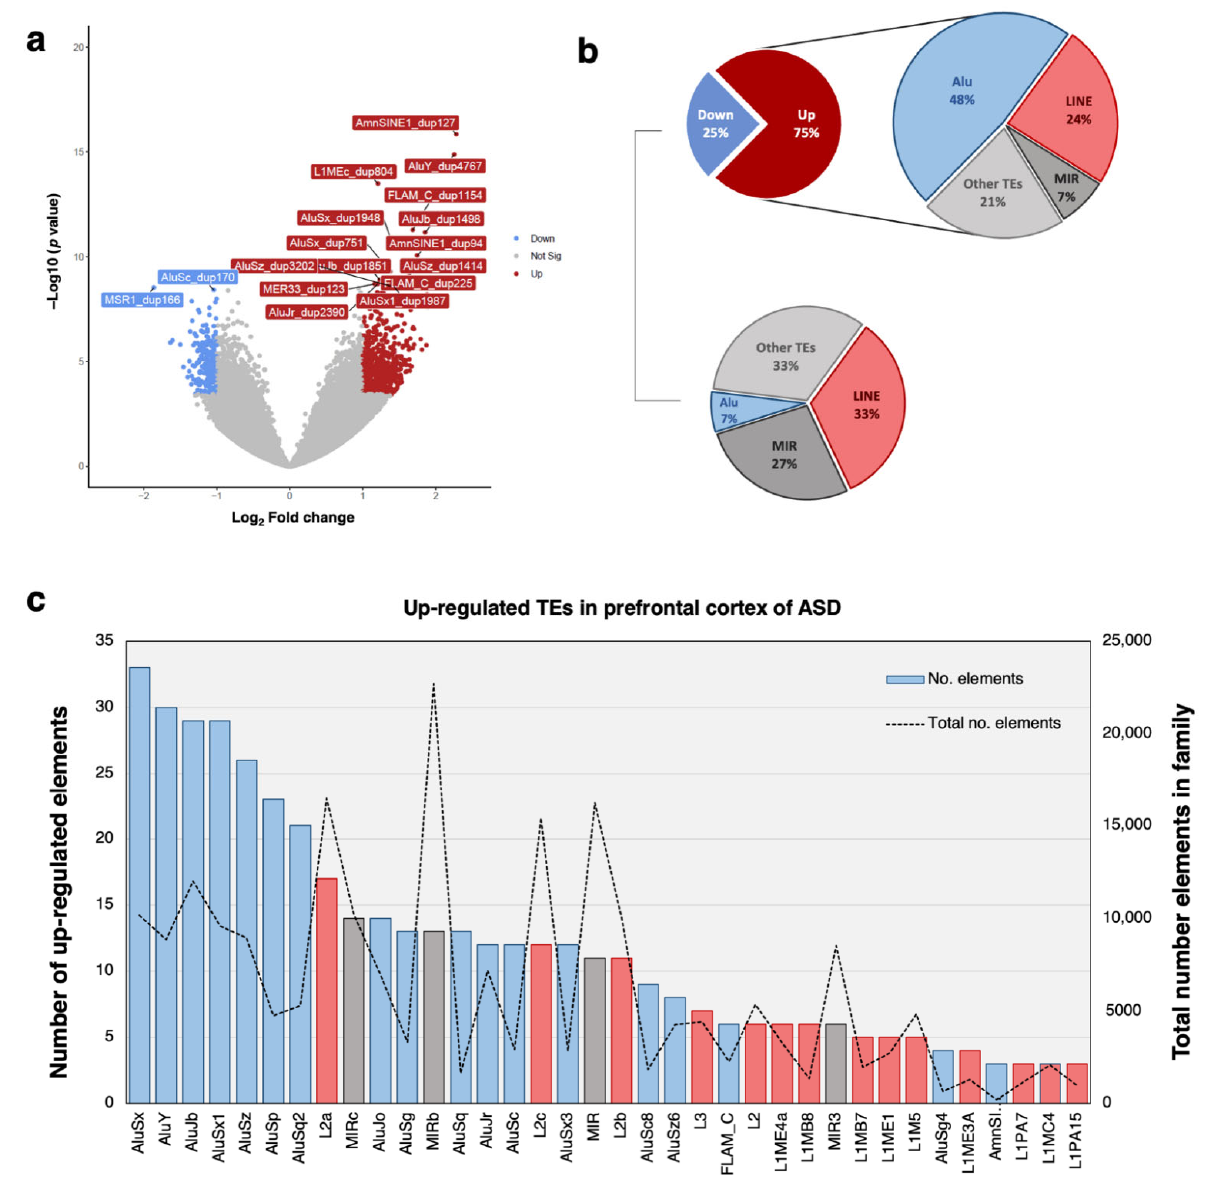
Figure 2. Transposable element profiling in the prefrontal cortex of ASD individuals: ( a ) Volcano plot of all individual TEs in the human genome. Dysregulated elements are labeled at a significance threshold (BH-adjusted p < 0.01 and log 2 FC > 1), and the most significant elements are labeled with a symbol. ( b ) The distribution of DETEs per family from RNA-seq analysis. ( c ) The number of upregulated elements per TE family in the prefrontal cortex of ASD individuals. The top TE family with the highest number of upregulated elements is shown on the left y-axis. The number of total elements in each TE family is shown on the right y-axis. Red bars represent Alu elements, blue bars represent LINE elements, and gray bars represent